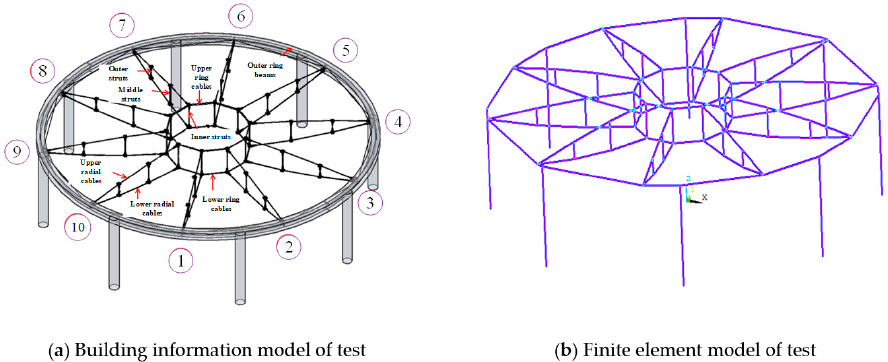
Figure 5. Model for the test of the wheel-spoke cable